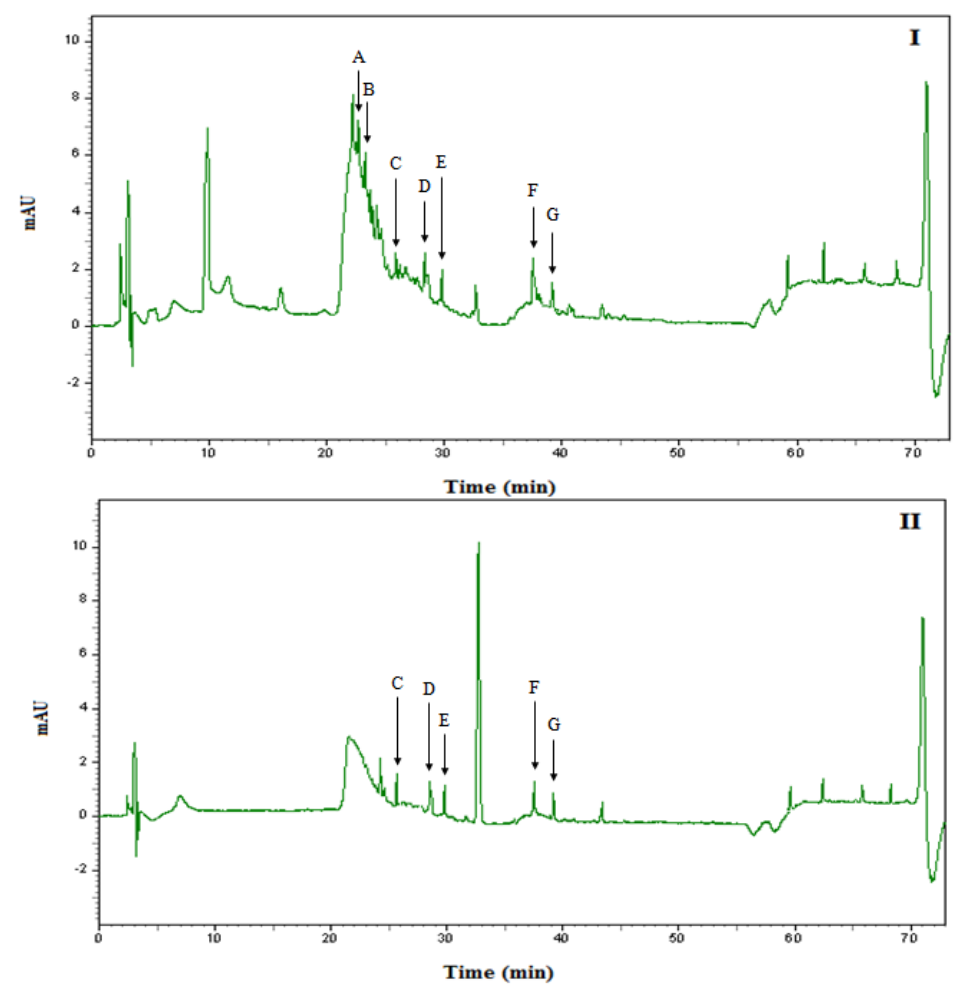
Figure 4. Chromatogram of Phenolic acid and Flavonoids detected in Malaysian Nenas honey using HPLC-UV absorption at (I) 290 nm and (II) 340 nm. A = chlorogenic acid, B = caffeic acid, C = p -coumaric acid, D = rutin, E = ellagic acid, F = quercetin, G =